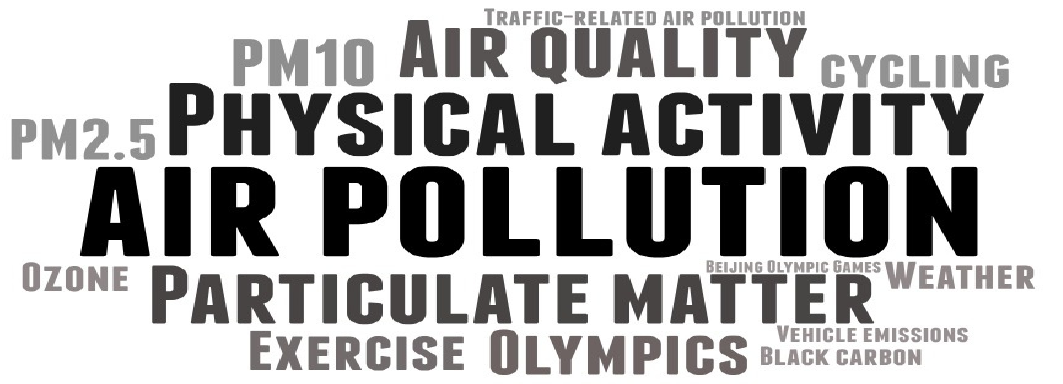
Figure 3. Keywords used in published studies.